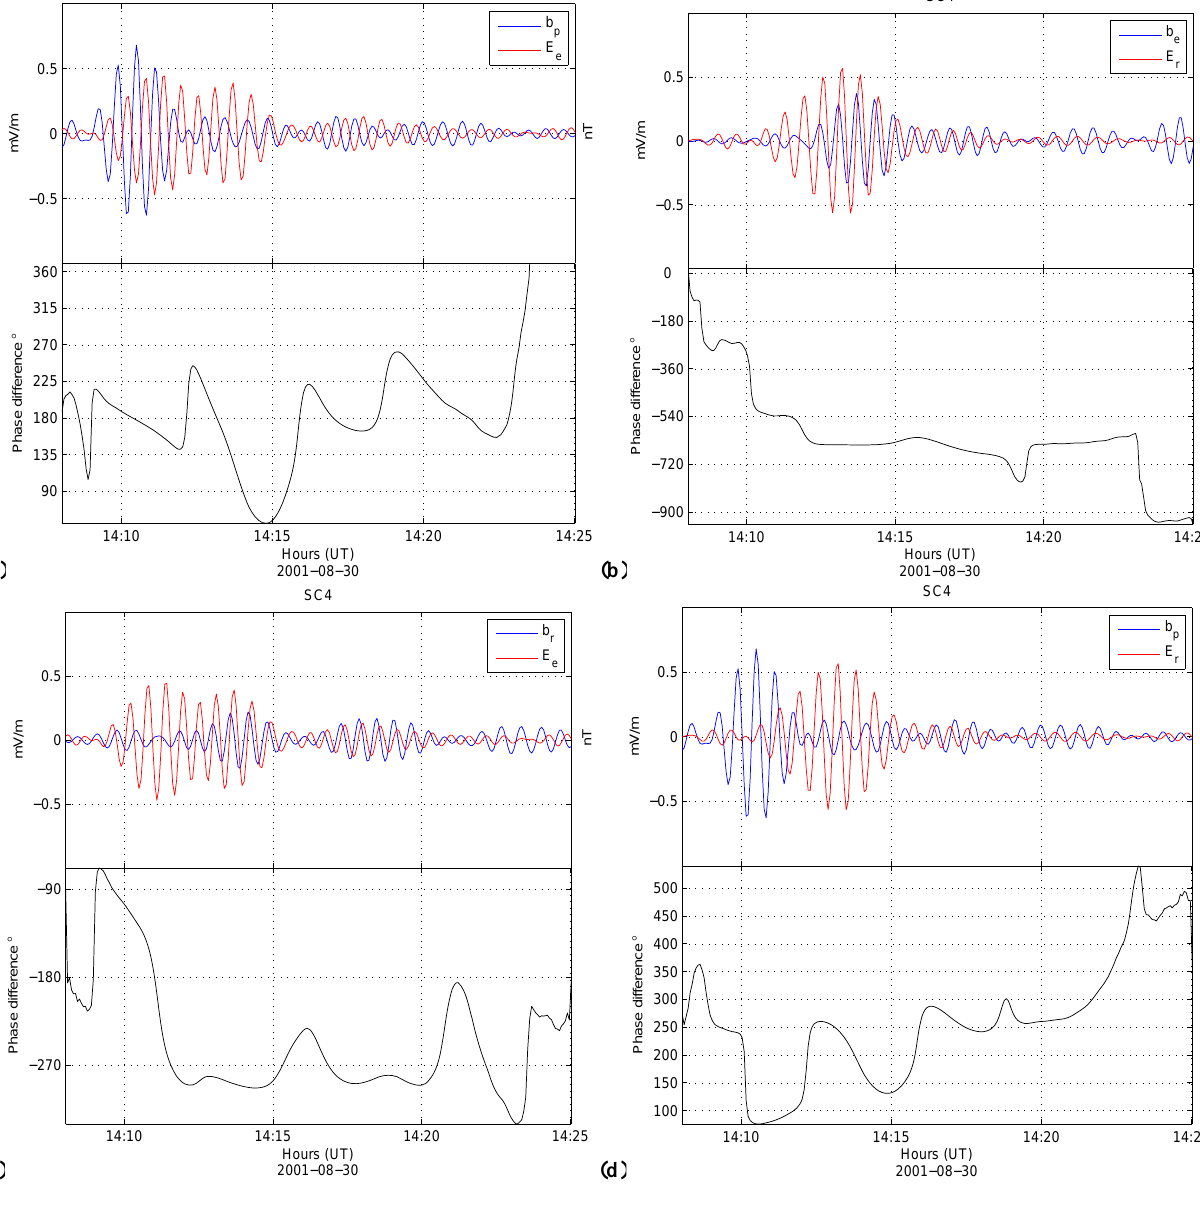
(Fig. 8c) we see only small oscillations in the beginning of the event, again we might speculate that these are associ- ated with the compressional mode. Like the 6.8 mHz wave the 27 mHz pulsation also has a complicated relationship be- tween the parallel magnetic component and the radial elec- tric component (Fig. 8d). The b p component oscillates for approximately two periods before the E r component starts to increase in amplitude. This increase continues even after the b p component starts to